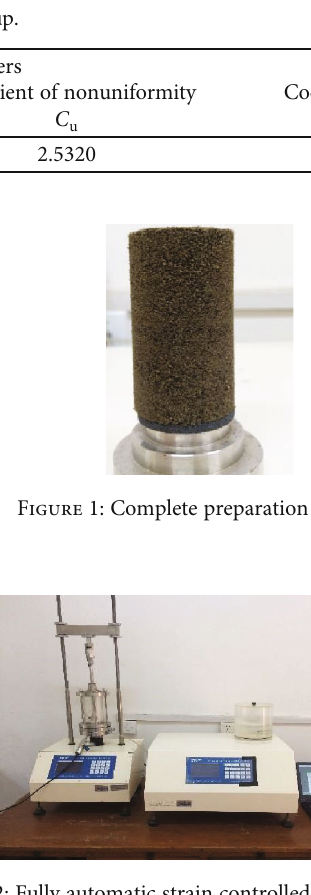
Figure 2: Fully automatic strain controlled triaxial